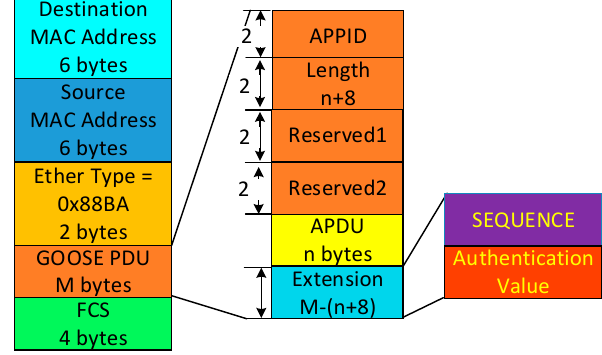
Figure 7. Extension field of GOOSE APDU according to IEC 62351-6.